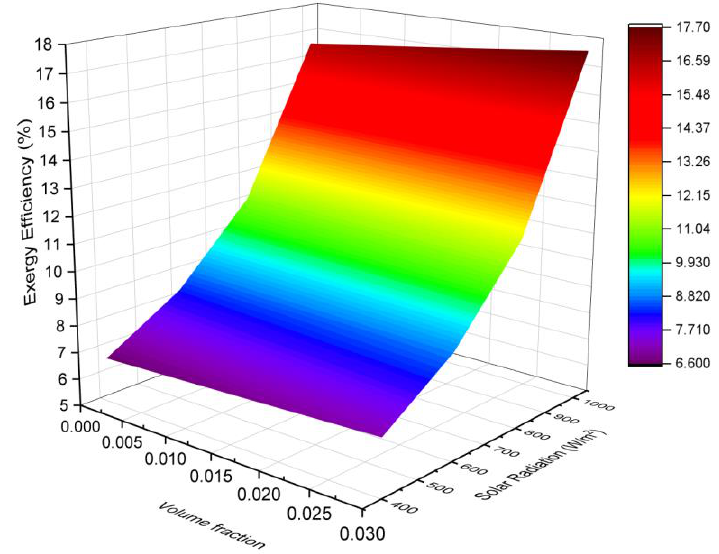
Figure 9. Influence of solar radiation and volume fraction on exergy efficiency.